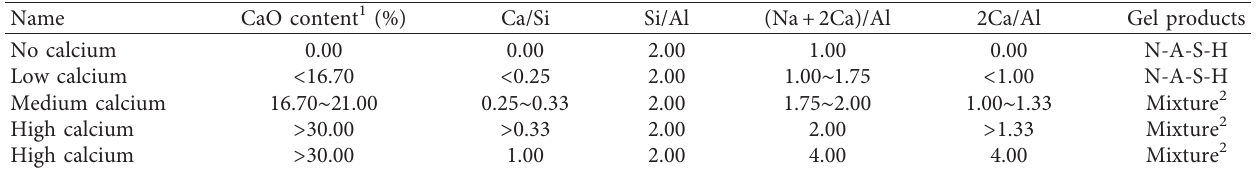
Table 1: Elemental composition, structural characteristics, and product identification of alkali-activated aluminosilicate systems based on molecular dynamics